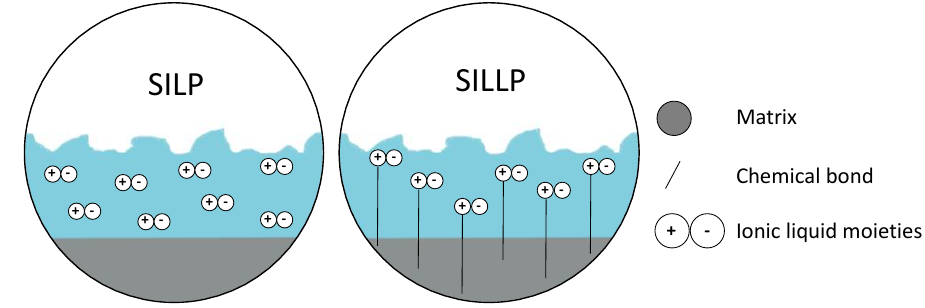
Figure 2. Supported ionic liquid phase (SILP) and supported ionic liquid-like phase (SILLP).